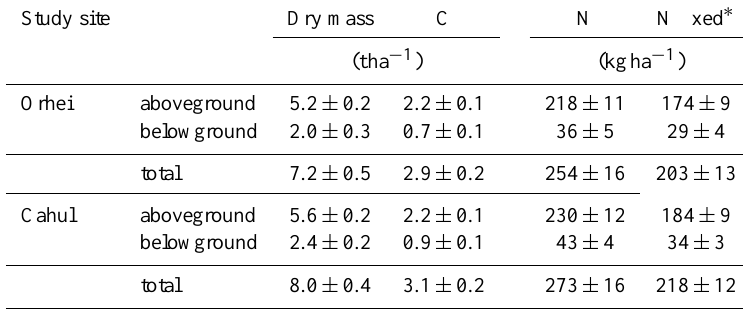
Table 1. Dry masses (above- and belowground) of vetch and related input of C and N at Orhei and Cahul (mean values ± SD, n = 3). Study site Dry mass C N N fixed ∗ (tha − 1 ) (kgha − 1 ) Orhei aboveground 5 . 2 ± 0 . 2 2 . 2 ± 0 . 1 218 ± 11 174 ± 9 belowground 2 . 0 ± 0 . 3 0 . 7 ± 0 . 1 36 ± 5 29 ± 4 total 7 . 2 ± 0 . 5 2 . 9 ± 0 . 2 254 ± 16 203 ± 13 Cahul aboveground 5 . 6 ± 0 . 2 2 . 2 ± 0 . 1 230 ± 12 184 ± 9 belowground 2 . 4 ± 0 . 2 0 . 9 ± 0 . 1 43 ± 4 34 ± 3 total 8 . 0 ± 0 . 4 3 . 1 ± 0 . 2 273 ± 16 218 ± 12